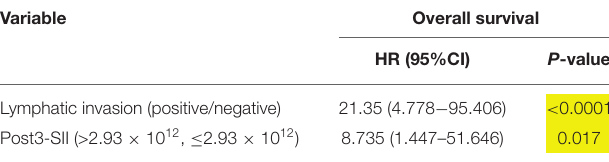
TABLE 4 | Multivariate analysis of patient survival ( n =